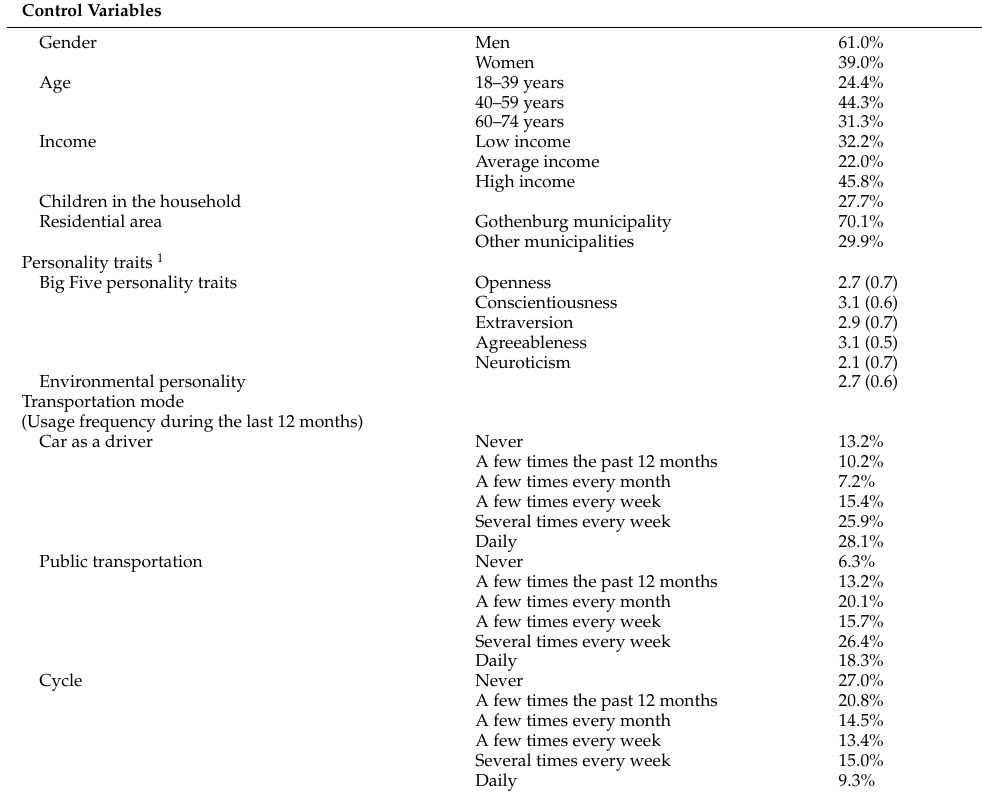
Table 1. Aggregated measures of the study sample ( N =